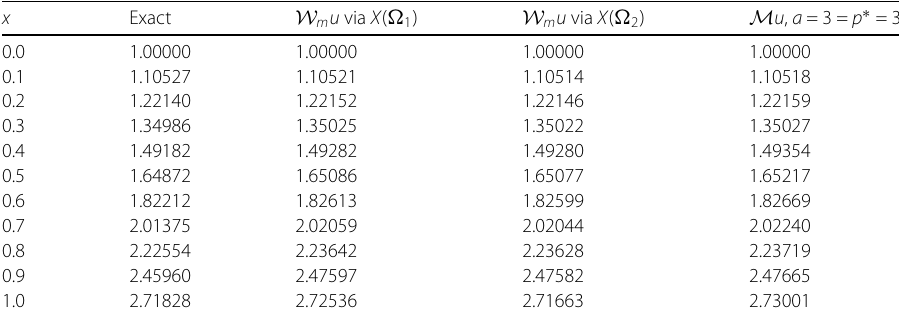
Table 3 Numerical results of Example 4.1 using the framelet systems X ( (cid:7) 1 ) and X ( (cid:7) 2 ) for m = 3 and λ = 3.75